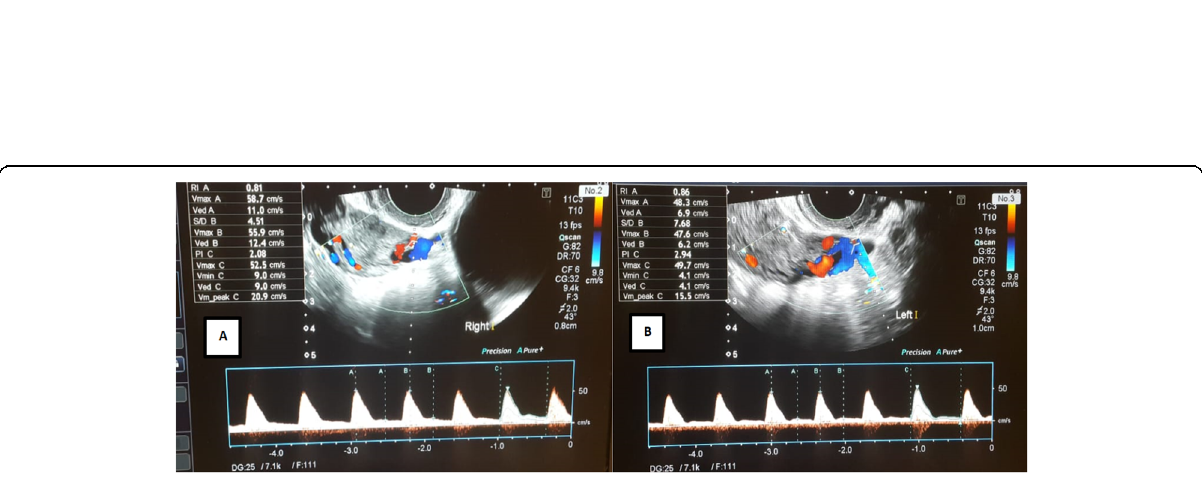
Fig. 9 a , b Transvaginal Doppler ultrasound of both uterine arteries ( a right, b left) of female patient aged 26 years old diagnosed with unexplained infertility shows RI of right and left uterine arteries were 0.81 and 0.86 respectively with mean RI 0.83, S/D ratios of right and left uterine arteries were 4.51 and 7.68 respectively with mean S/D ratio 6.09, and PI of right and left uterine arteries were 2.08 and 2.94 respectively with mean PI 2.51